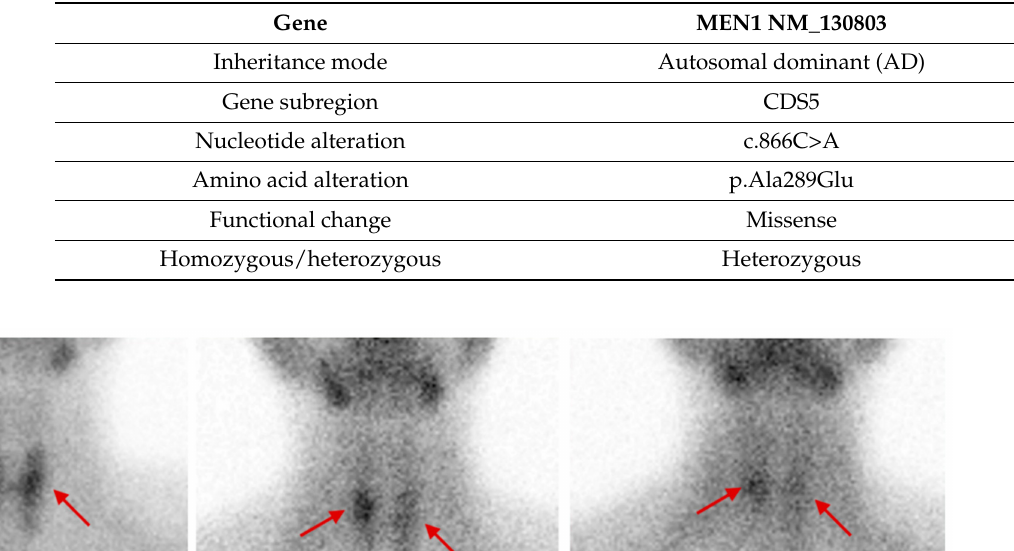
Table 1. MEN1 genetic detecting analysis.